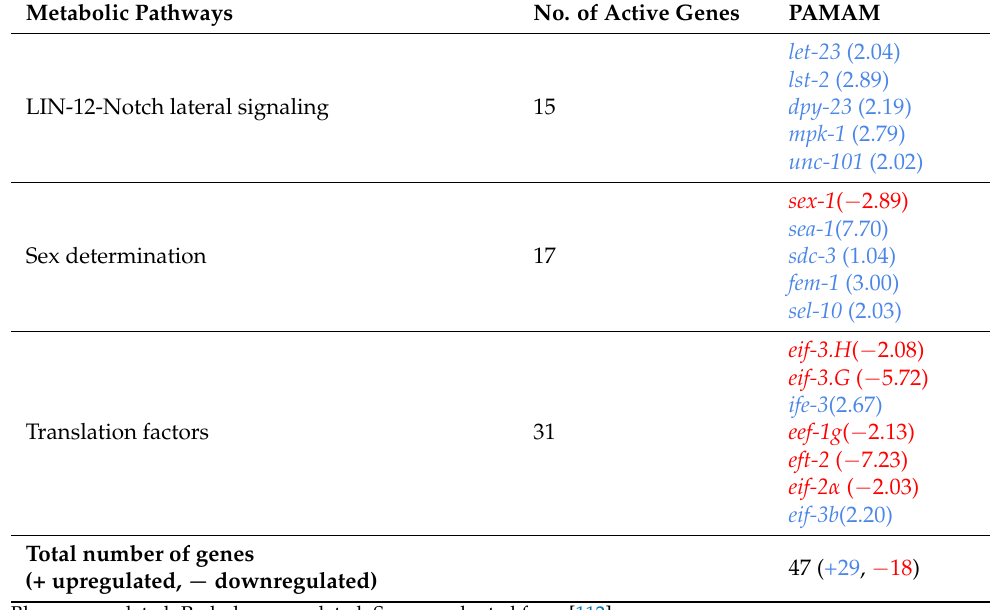
Table 2. Cont . Metabolic Pathways No. of Active Genes PAMAM